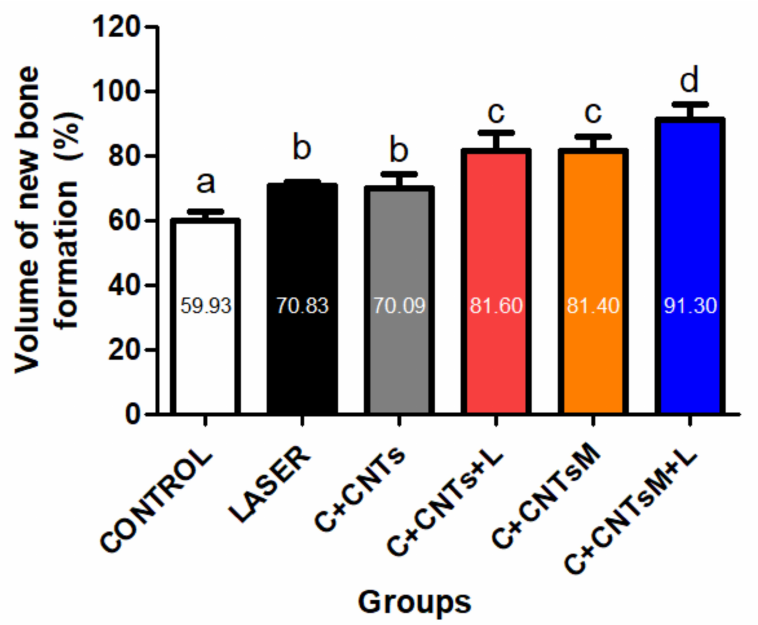
Figure 8. Bone volume (%) formed in the defect area. The means and standard deviation of the rela- tive percentage volume of newly formed bone in the femoral defects in the study groups were: 59.93 ± 3.04 (G1/Control), 70.83 ± 1.21 (G2/Laser), 70.09 ± 4.31 (G3/C+CNTs), 81.6 ± 5.74 (G4/C+CNTs+L), 81.4 ± 4.57 (G5/C+CNTsM) and 91.3 ± 4.81 (G6/C+CNTsM+L), respectively. Different lowercase letters indicate a significant difference between the groups. (a (cid:54) = b (cid:54) = c (cid:54) = d; p <